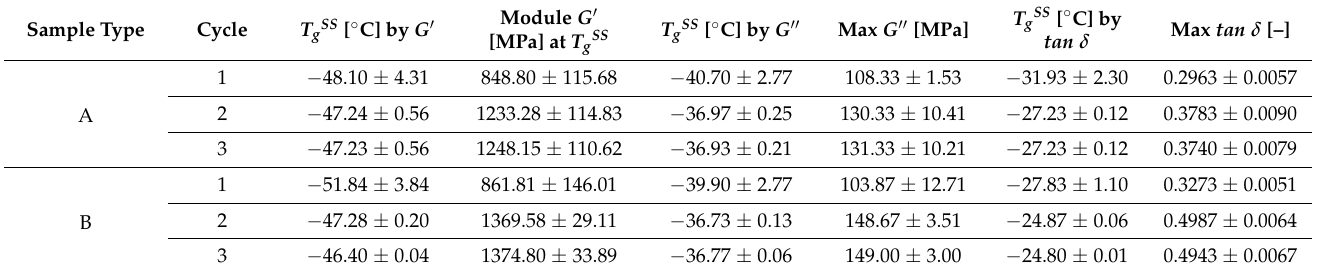
Figure 10. Determination of polyurethane glass transition temperature based on the loss factor tan δ . Table 3. T g SS values determined in DMTA